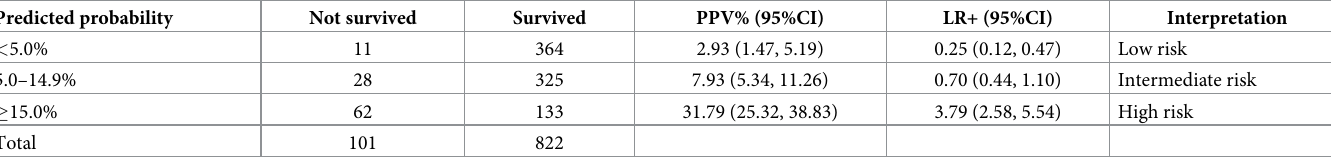
Abbreviations: CI, confidence interval; PPV, positive predictive value; LR+, positive likelihood